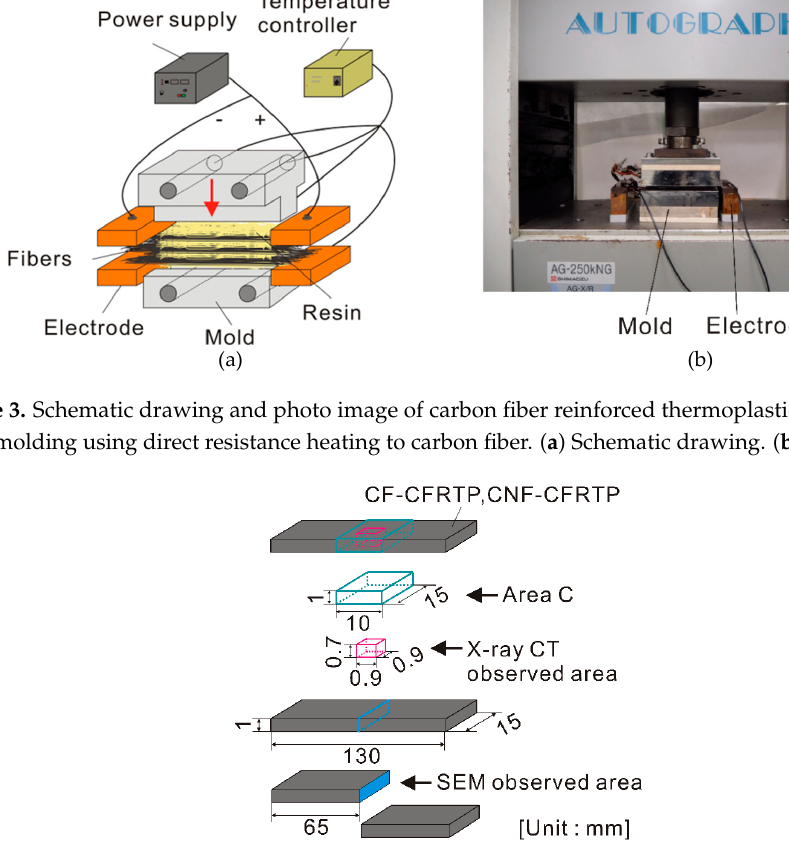
Figure 4. Observed area of X-ray microscope and SEM.